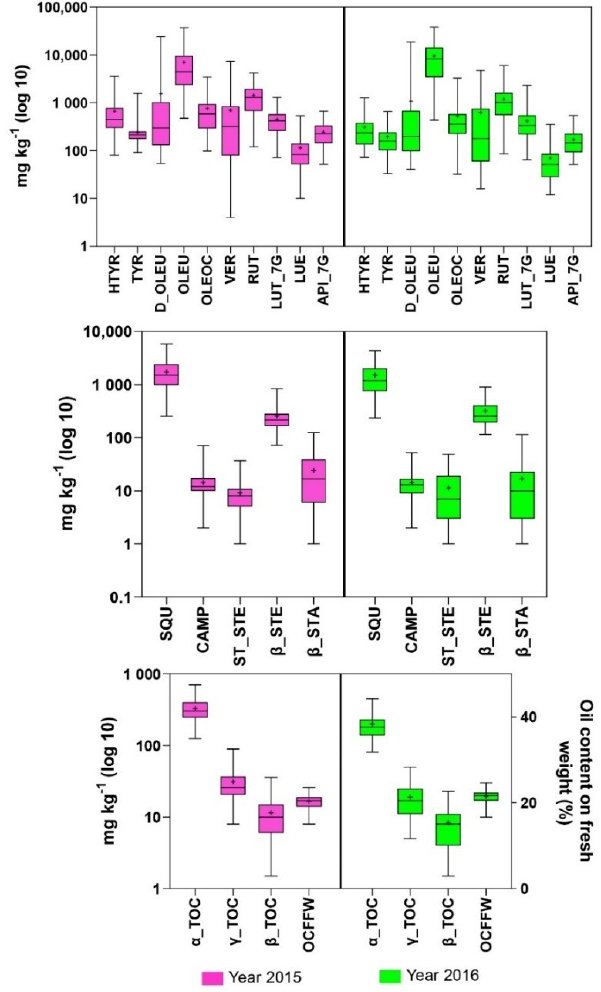
Figure 3. Box and whisker plots for trait variation in each crop season. Each plot shows the distribution of data for 61 cultivars from the minimum to the maximum level, with horizontal inner line showing the data median. The dot sign inside each box shows the mean value. The data are expressed as mg kg ‐ 1 of fruit pulp.